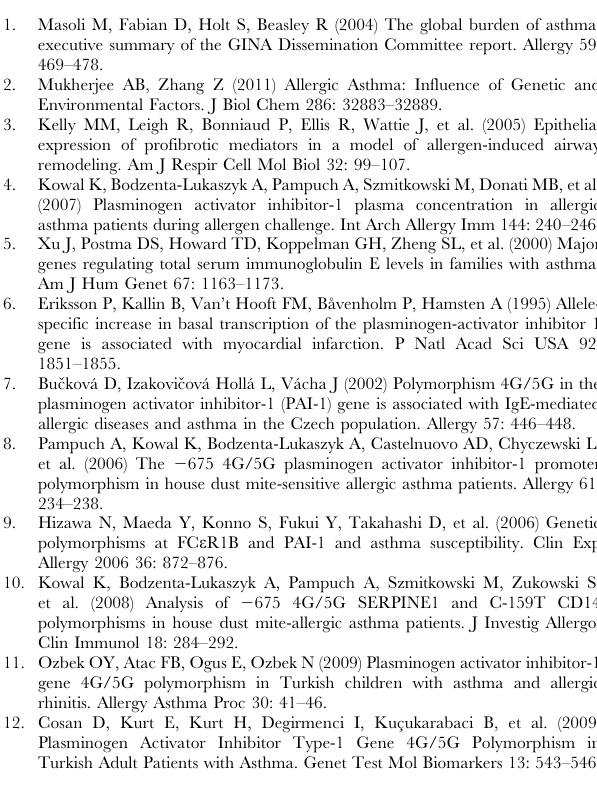
Table S1 Characteristics of the 9 case-control studies included in meta-analysis. Table S2 Distribution of PAI-1 genotype among patients with asthma and controls included in the meta-analysis.